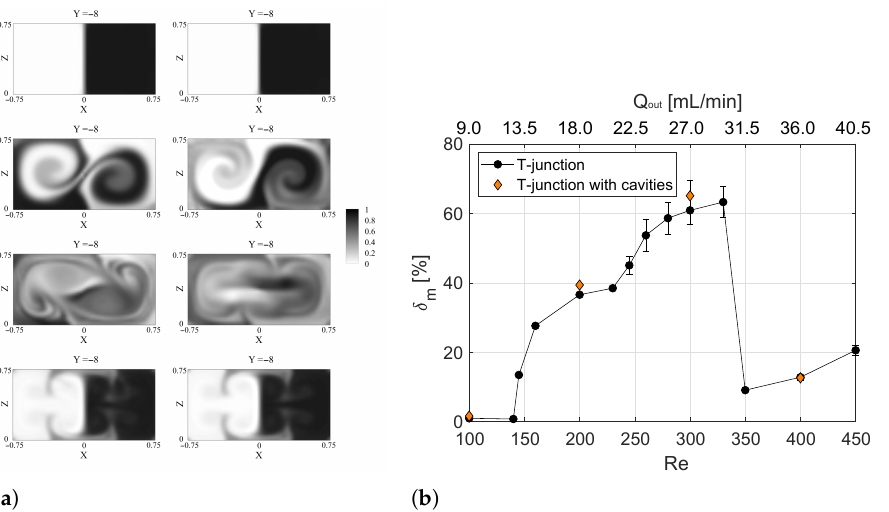
Figure 3. ( a ) Contours of non-dimensional dye concentration at the Y = − 8 cross-section along the mixing channel for the TJ case (left panel) and the TJC case (right panel) from top to bottom: Re = 100, Re = 200, Re = 300, and Re = 400. ( b ) Degree of mixing evaluated at the Y = − 8 cross-section as a function of Reynolds number and of the volumetric flow rate of water ( Q out ) in the outlet channel.